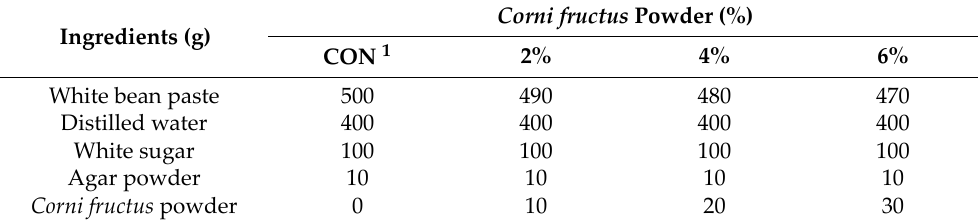
Table 1. Formulation of Yanggaeng treated with Corni fructus